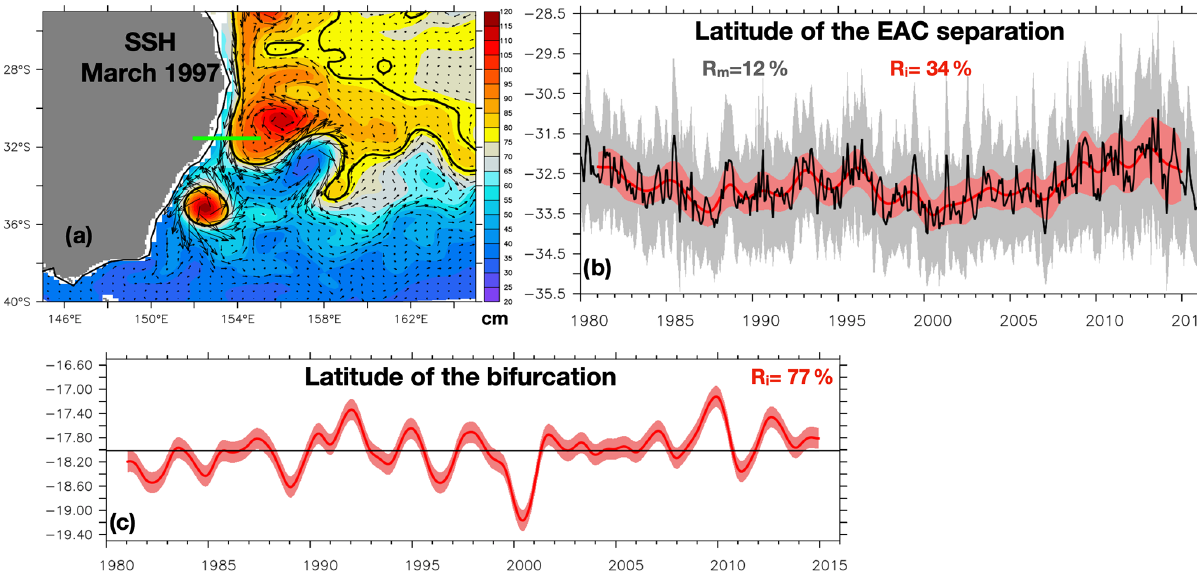
Figure 6. (a) Sea surface height (SSH) snapshot from one member on 15 March 1997 (colors), with the isoline associated with the maximum southward geostrophic current at 28 ◦ S (thick black line), and geostrophic surface currents (vectors). The latitude of the EAC separation in that snapshot, at which the isoline veers eastward, is indicated by the thick green line. (b) Time series of the latitude of EAC separation. In black: monthly values from the ensemble mean; in grey shades is the ensemble mean plus or minus the monthly ensemble spread. In red: interannual values from the ensemble mean, and the red shades represent the ensemble mean plus or minus the interannual ensemble spread. The percentage of the deterministic variance is given as R m for the monthly values and R i for the interannual values. (c) Time series of the latitude of western boundary current bifurcation. In red: interannual values from the ensemble mean, and the red shades represent the ensemble mean plus or minus the interannual ensemble spread. In black: the 1980–2015 average latitude of the bifurcation. The percentage of the deterministic variance is given as R i for the interannual